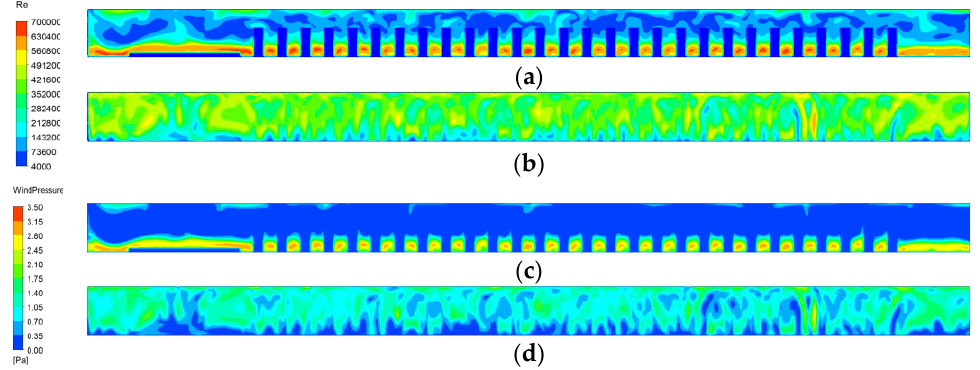
Figure 8. Wind pressure ventilation characteristics in the high-altitude area of: ( a ) x = 4000 mm, Re; ( b ) x = 600 mm, Re; ( c ) x = 4000 mm, wind pressure; ( d ) x = 600 mm, wind pressure.